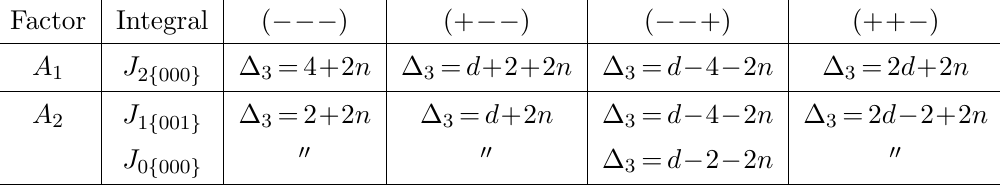
Table 5 . Singularities arising in triple- K integrals for the form factors of h J (cid:22) 1 J (cid:22) 2 O I i . Singularity type